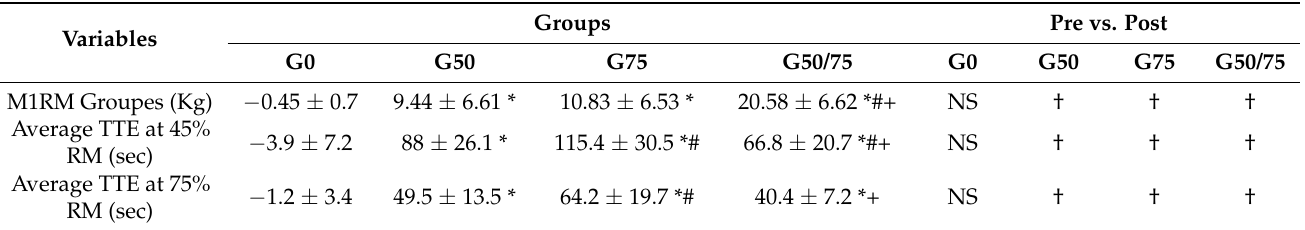
Table 6. Variation in average 1RM (M1RM) and average time to exhaustion (TTE) at 45 and 75%